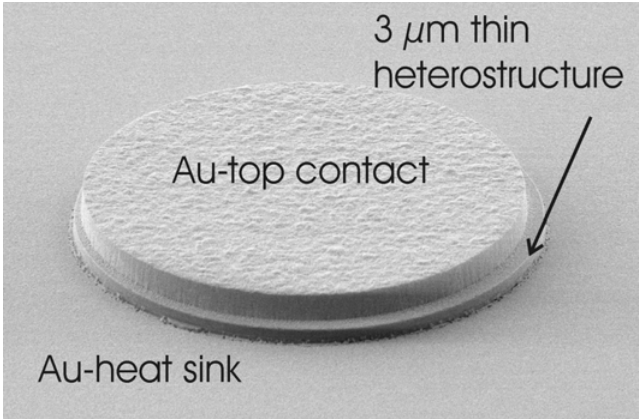
Figure 4. Gunn diode chip: 3µm Gunn-diode heterostructure between two thick Au contacts. Gunn diode chip packaging and mounting in an oscillator